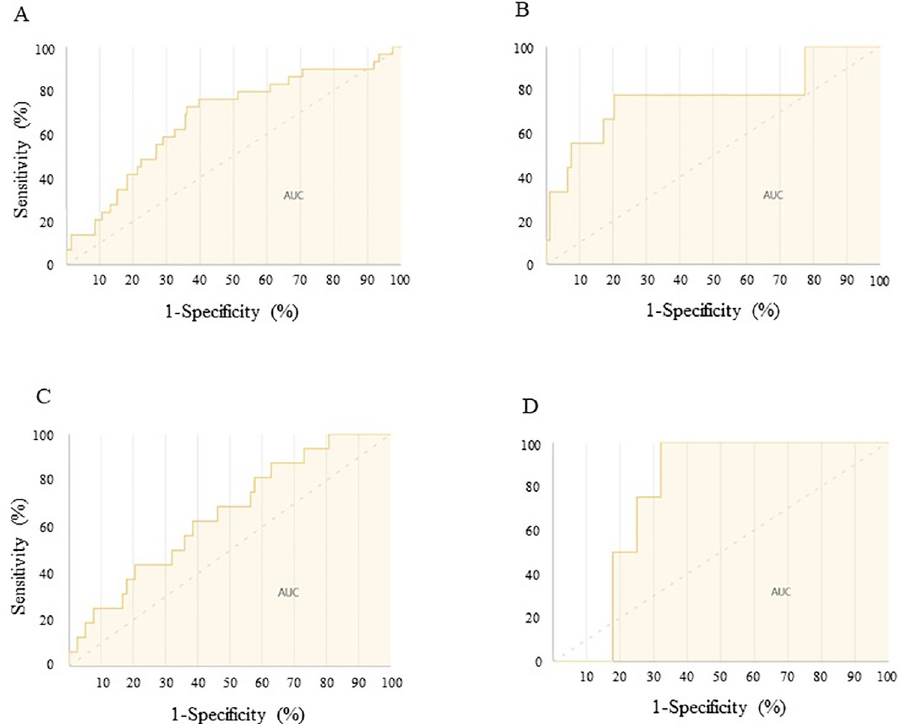
Fig 2. Receiver operating characteristic curve for prediction of the Cis-AKI. A: All patients, B: Under 65 years old, C: 65–74 years old, D: 75 years or older. Cis-AKI: Cisplatin-induced acute kidney injury, AUC: Area under the curve.